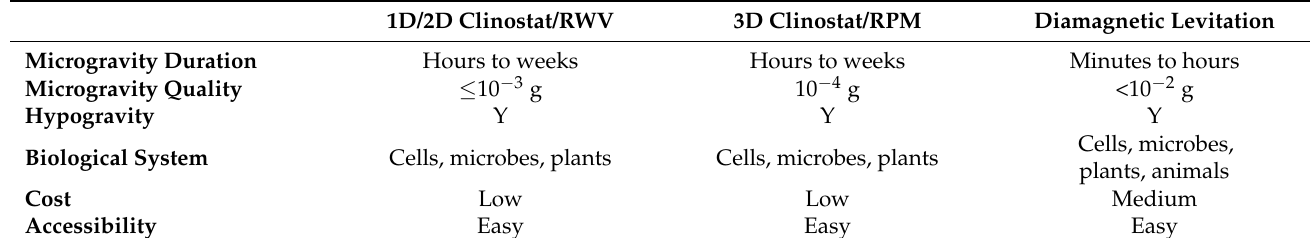
Table 1. Specifications of ground microgravity simulators. RWV, rotating wall vessel; RPM, random positioning machine.